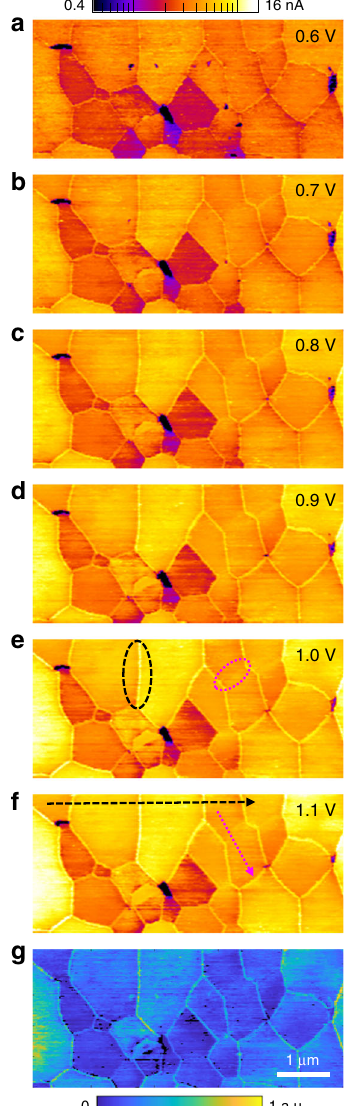
Fig. 3 2D mapping of photocurrent-voltage characteristics. a – f Montage of pc-AFM maps in a single 3 µ m × 6 µ m T-AFM polished region for sequentially increasing biases from 0.6 V ( a ) up to 1.1 V ( f ). g 2D map of the calculated local product of µ N ph , which incorporates the slopes from pixel-by-pixel linear fi tting of the photocurrent vs . bias from ( a ) to ( f ) according to the drift equation. All of ( a ) – ( f ) share the same log-scale color contrast